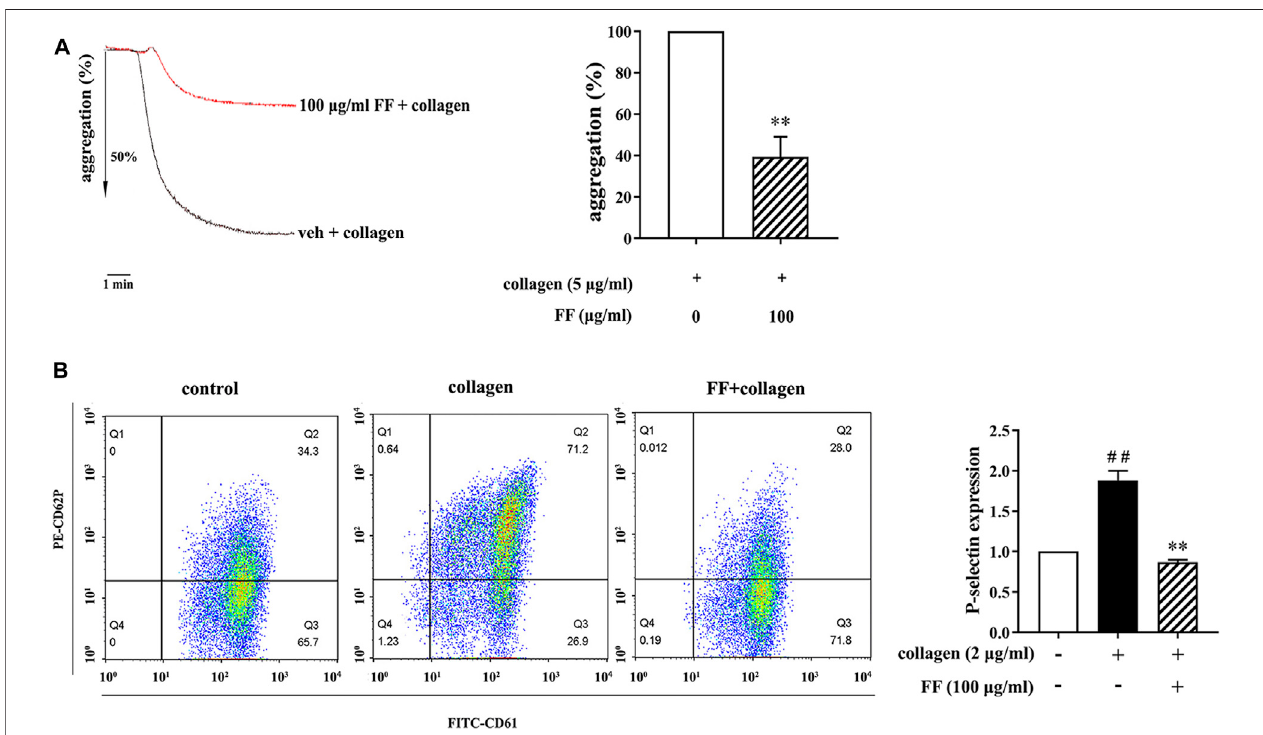
FIGURE1 | Fruit fl owinhibited platelet aggregation and P-selectin expression in collagen-stimulated platelets. Platelets were treated with vehicle (0.9% NaCl) or FF (100 μ g/ml) for 10 min, and then collagen was added for another 10 min. (A) Fruit fl ow inhibited platelet aggregation that was induced by collagen. Ordinate value is aggregation ratio and abscissa value is time (min). (B) Flow cytometry analysis of P-selectin expression. Fruit fl ow inhibited P-selectin expression that was induced by collagen. The data represent three independent experiments. * p < 0.05, ** p < 0.01, signi fi cant difference between FF-treated collagen-activated platelets and collagen-activated platelets alone. # p < 0.05, signi fi cant difference between collagen-treated platelets and